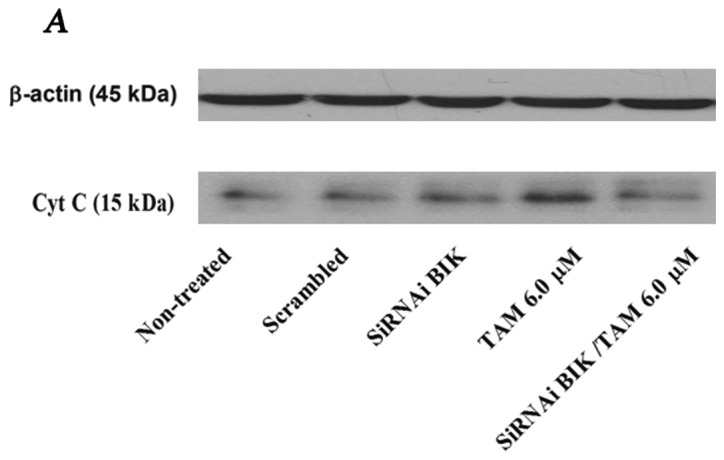
Silencing of Bik does not promote the release of cytochrome in response to tamoxifen. (A) Cell lysates were prepared and subjected to western blot analyses for cytochrome c (Cyt C) and β-actin as control. (B) Densitometry analysis of the expression levels of Cyt C. One representative of at least three independent experiments with similar results is shown. The groups were analyzed by one-way analysis of variance (ANOVA) with the Tukey’s test. *p<0.05; **p<0.01; ***p<0.001 vs. non-treated. Representative figures of three independent experiments carried out in triplicate are shown.